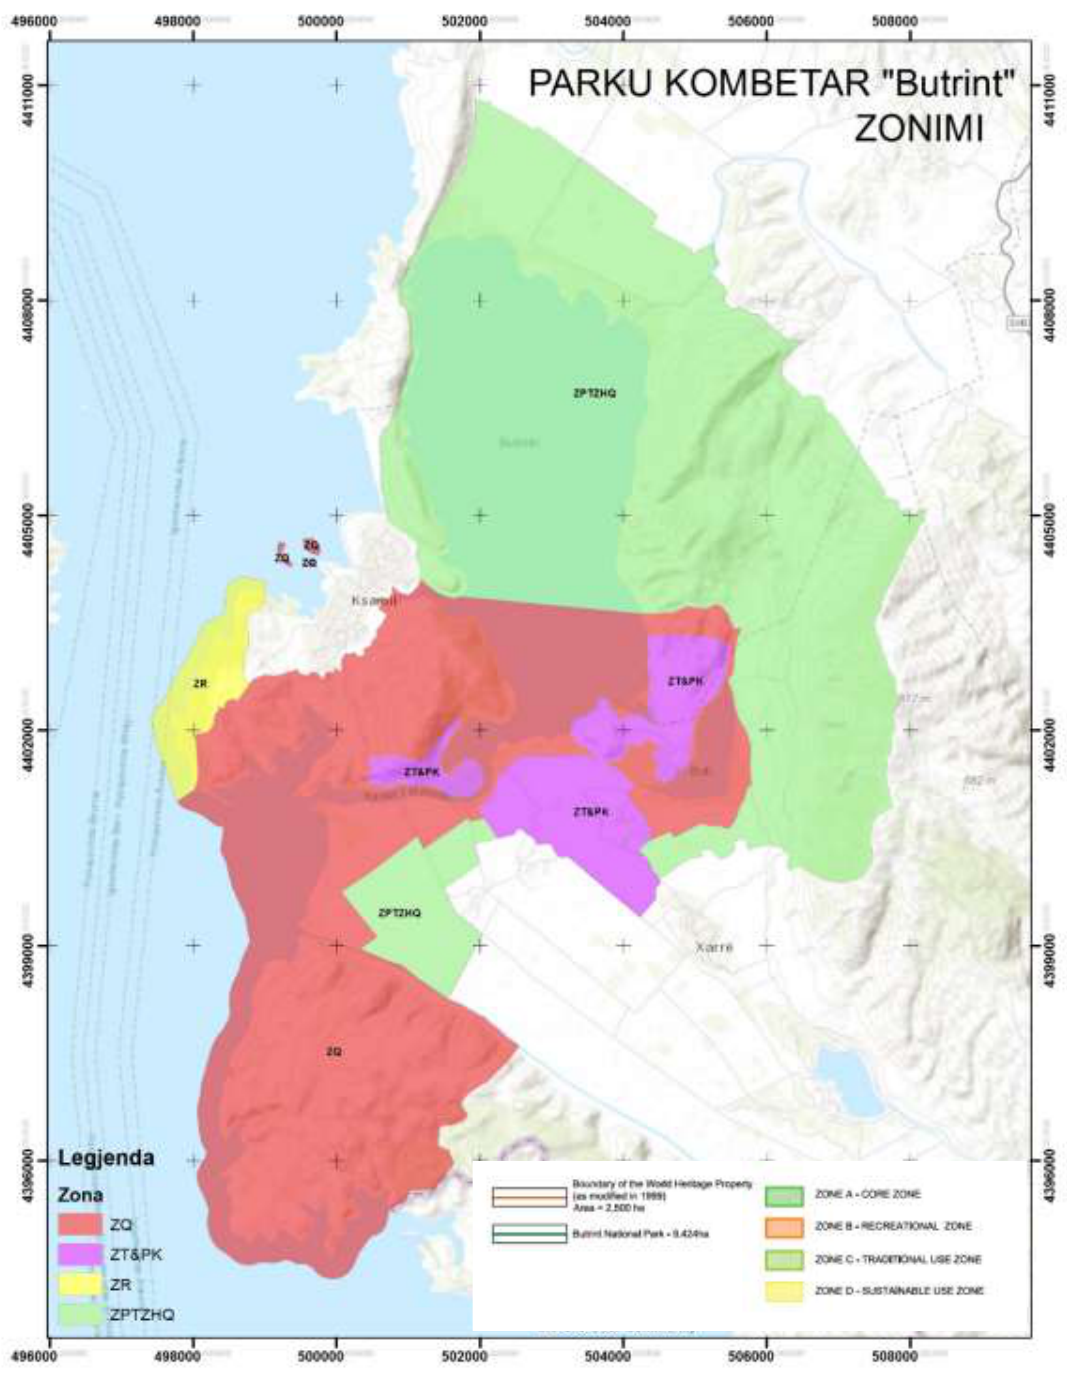
Figura 10: Nënzonat e propozuara të Parkut